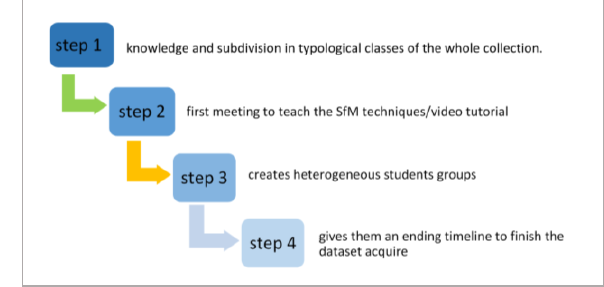
Figure 6. Methodology used in 2015 and 2016